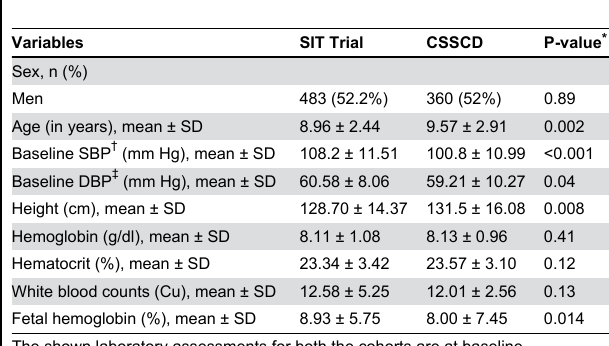
Table 1. Demographic and clinical characteristics of the SIT Trial and CSSCD